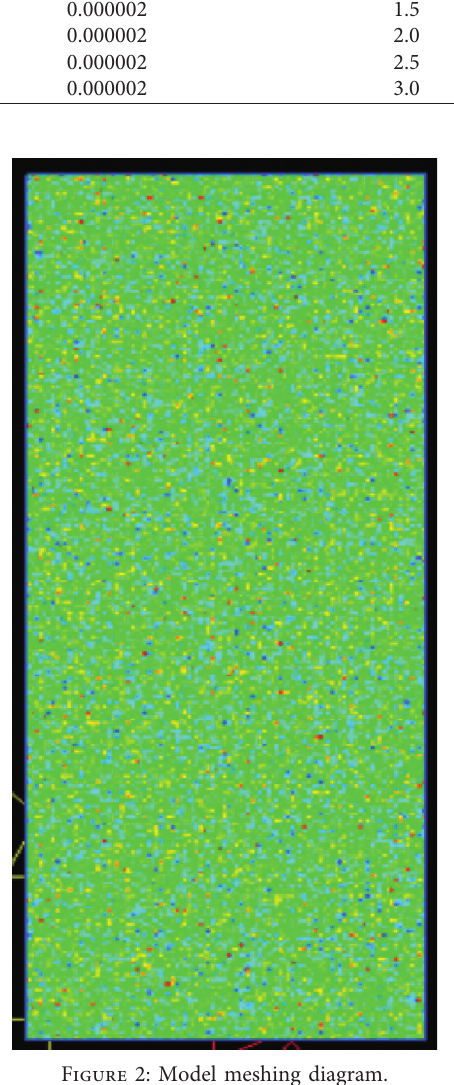
Figure 2: Model meshing